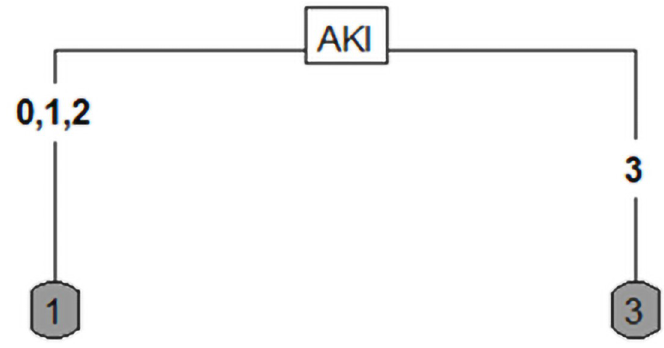
Fig 7. Remaining CKD, KRT, or recovery depending on the severity of AKI. CKD 1: Restitution to initial function, CKD 2: New onset or worsening of existing chronic kidney disease, CKD 3: Remaining KRT.